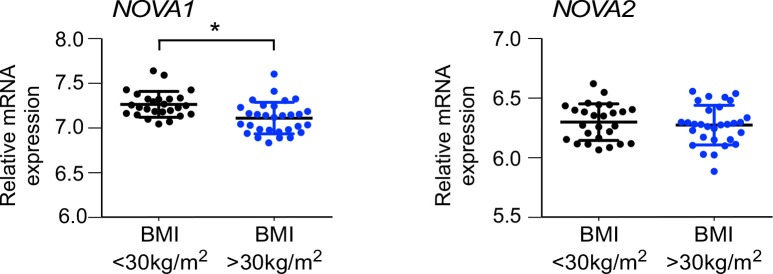
NOVA expression in human subcutaneous adipose tissue.NOVA1 and NOVA2 mRNA expression in abdominal subcutaneous adipose of obese (BMI>30 kg/m2) and non-obese (BMI<30 kg/m2) matched humans was examined (mean ± SEM; n = 30 obese, n = 26 non-obese; *p<0.05).